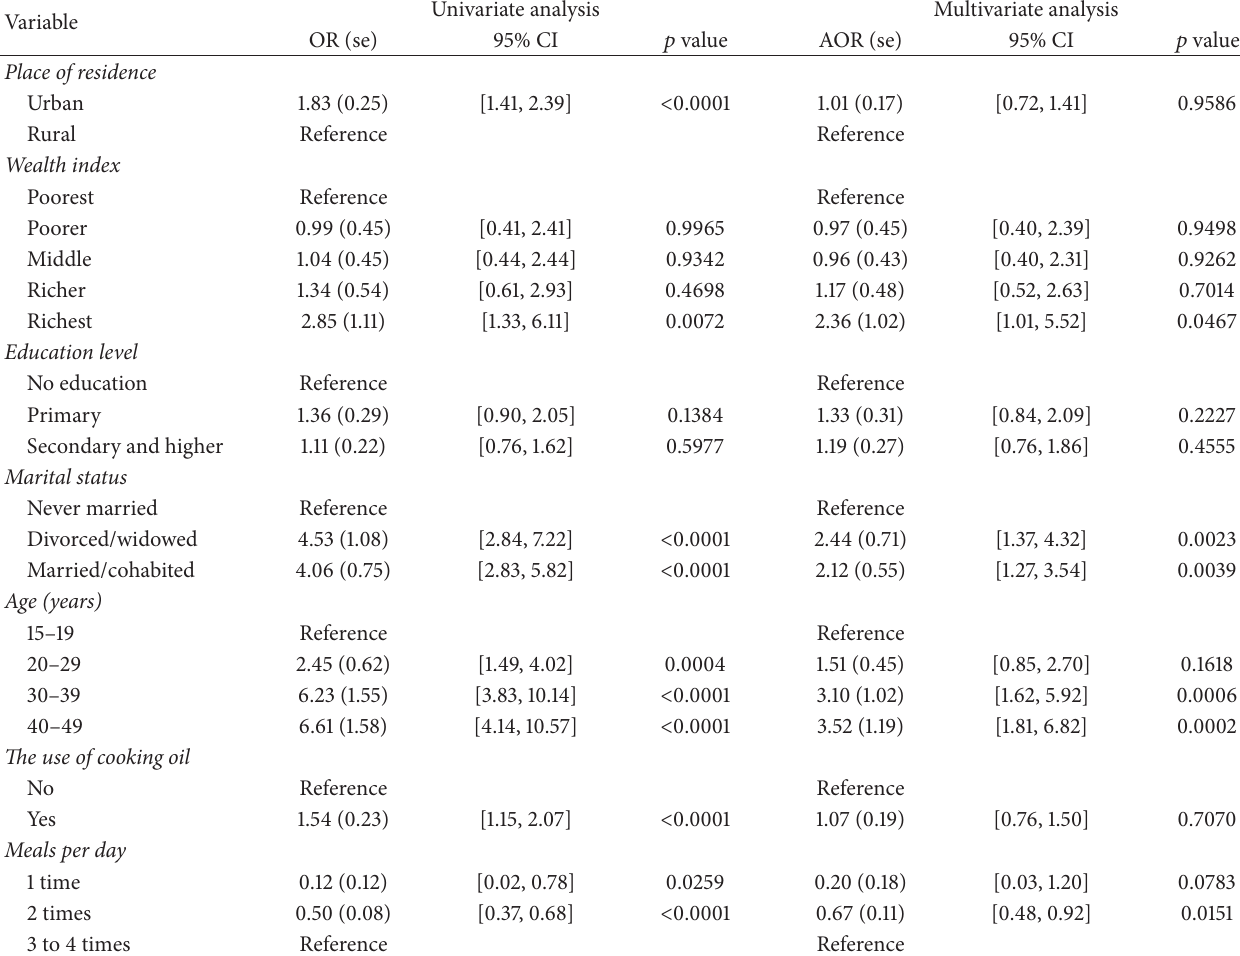
Table 4: Crude and adjusted odds ratios of obesity among nonpregnant women in